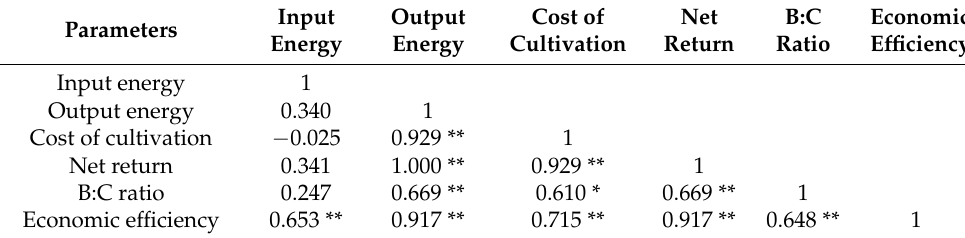
Table 8. Pearson’s correlation among different parameters.